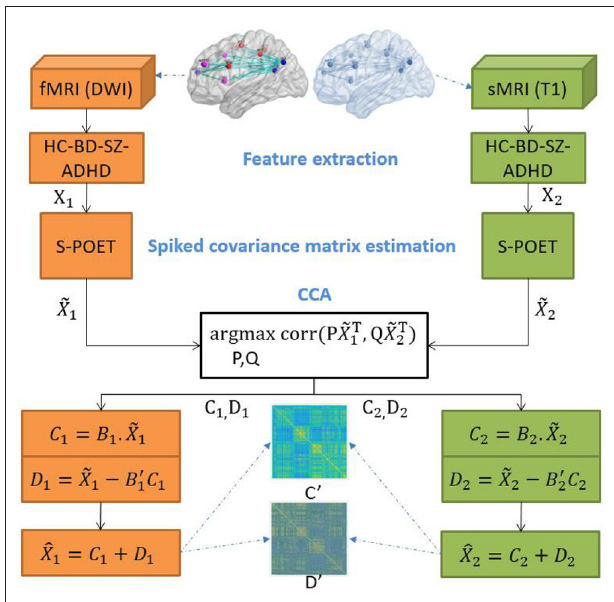
FIGURE 1 | Overview of the architecture of the proposed integration